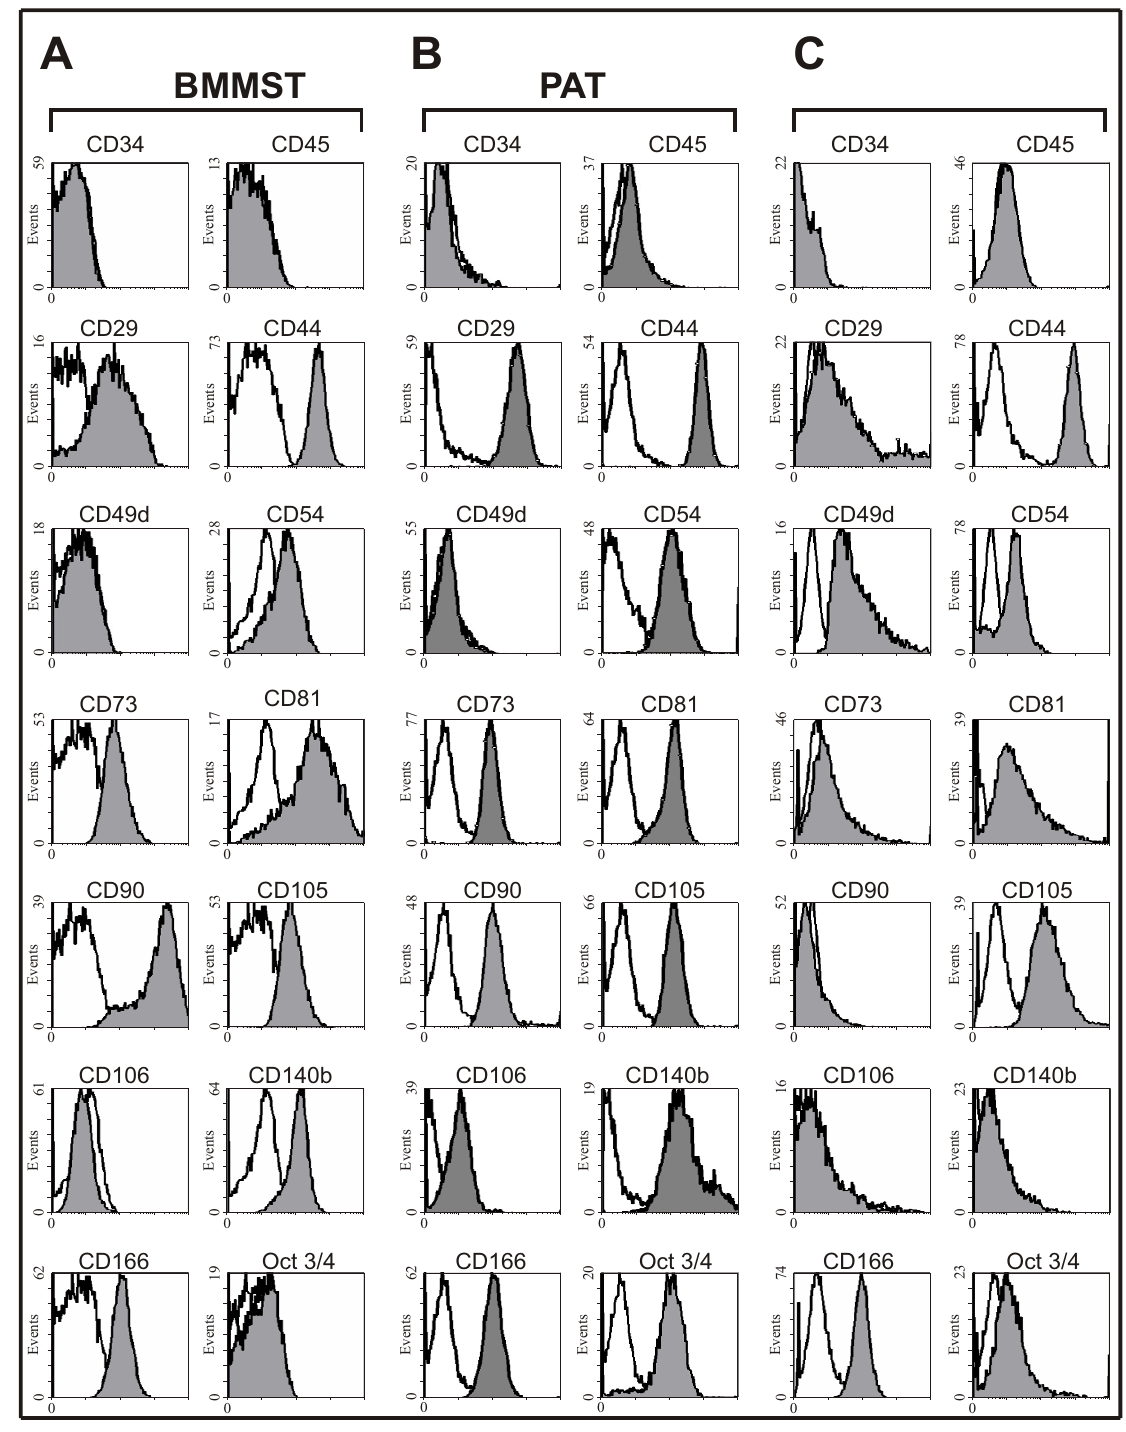
Figure 2 Flow cytometric characterization of mesenchymal progenitor cells derived from murine bone marrow (BM; A), perirenal adipose tissue (PAT; B), and mediastinal stromal tissue (MST; C). The background staining was assessed by isotype control (white). The specific markers are shown in